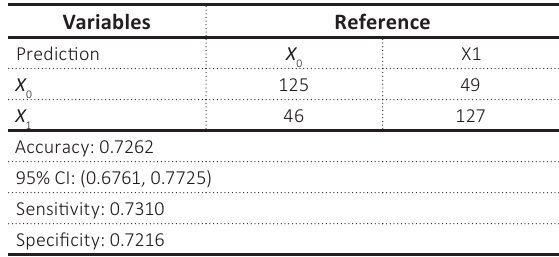
Table 6. Results of logistic